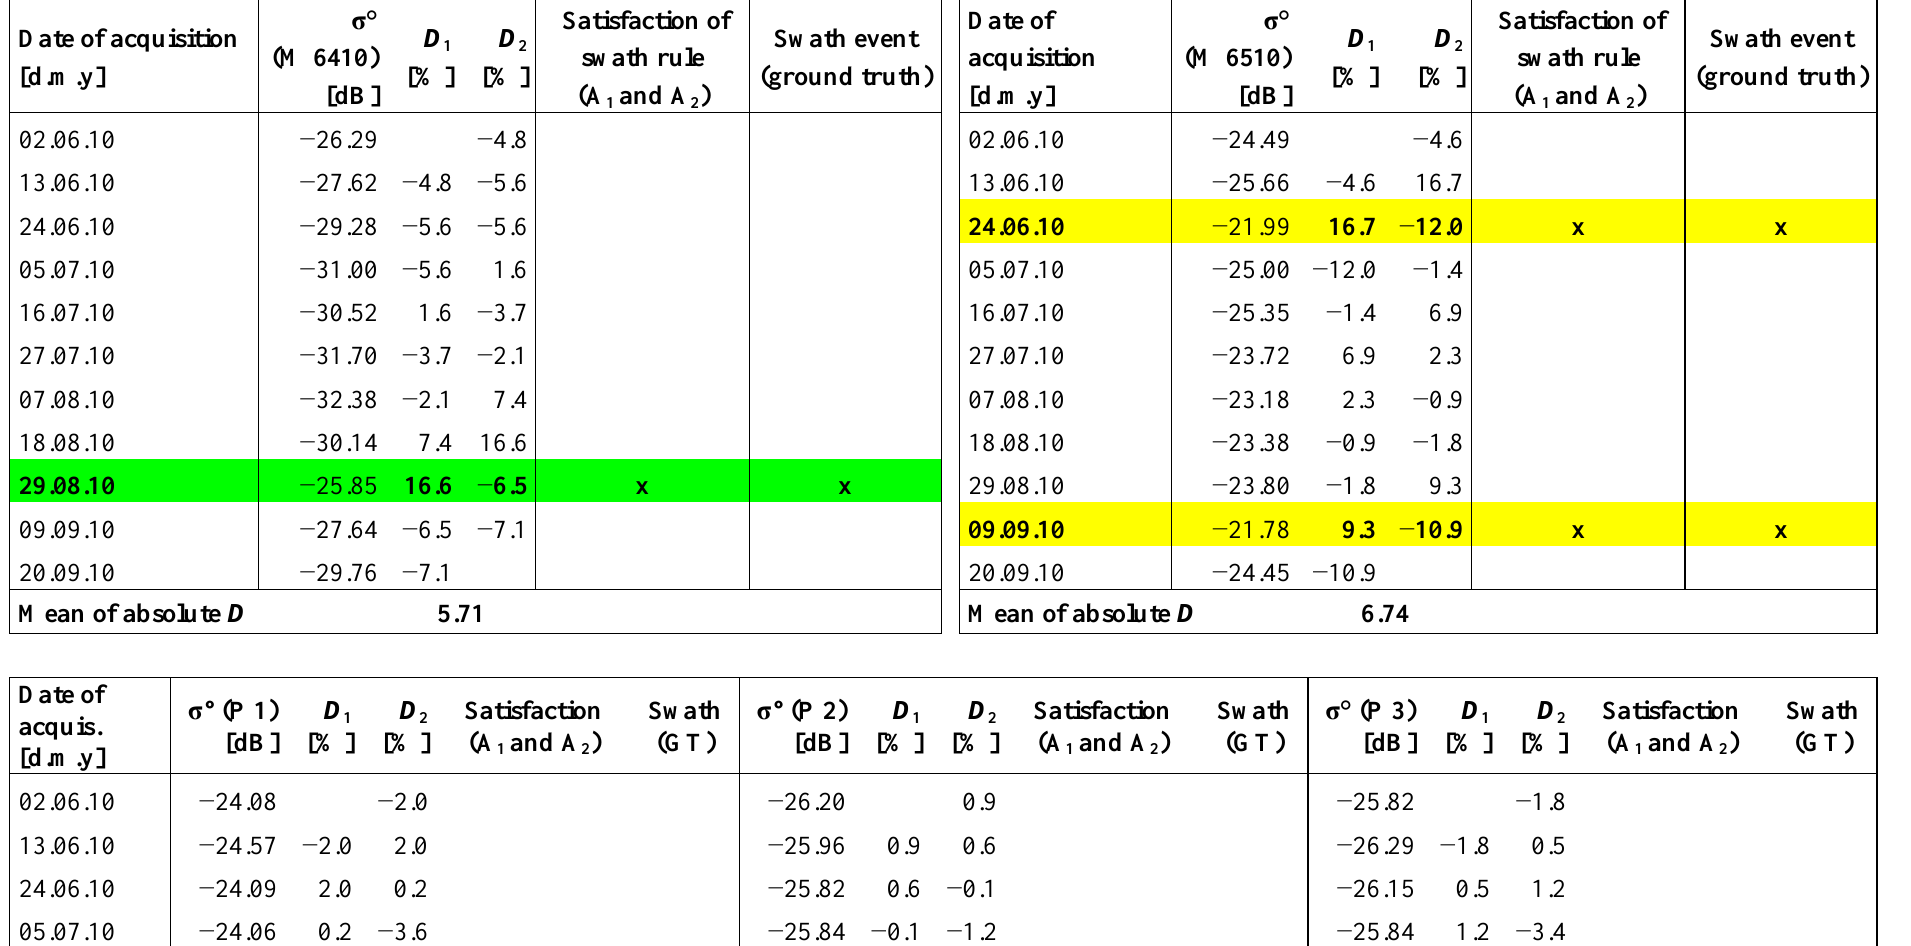
and A ) in comparison 1 2